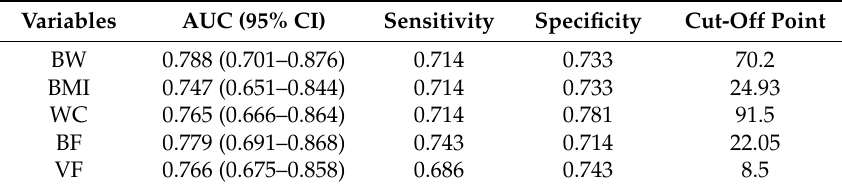
Table 3. The AUC, Sensitivity, and Specificity by the Most Optimal Cut-Off Point of Different Obesity Indices in Predicting